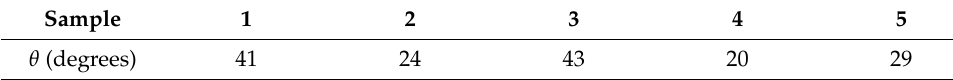
Table 3. VF inclination angle θ from the transverse axis ( Y -axis).